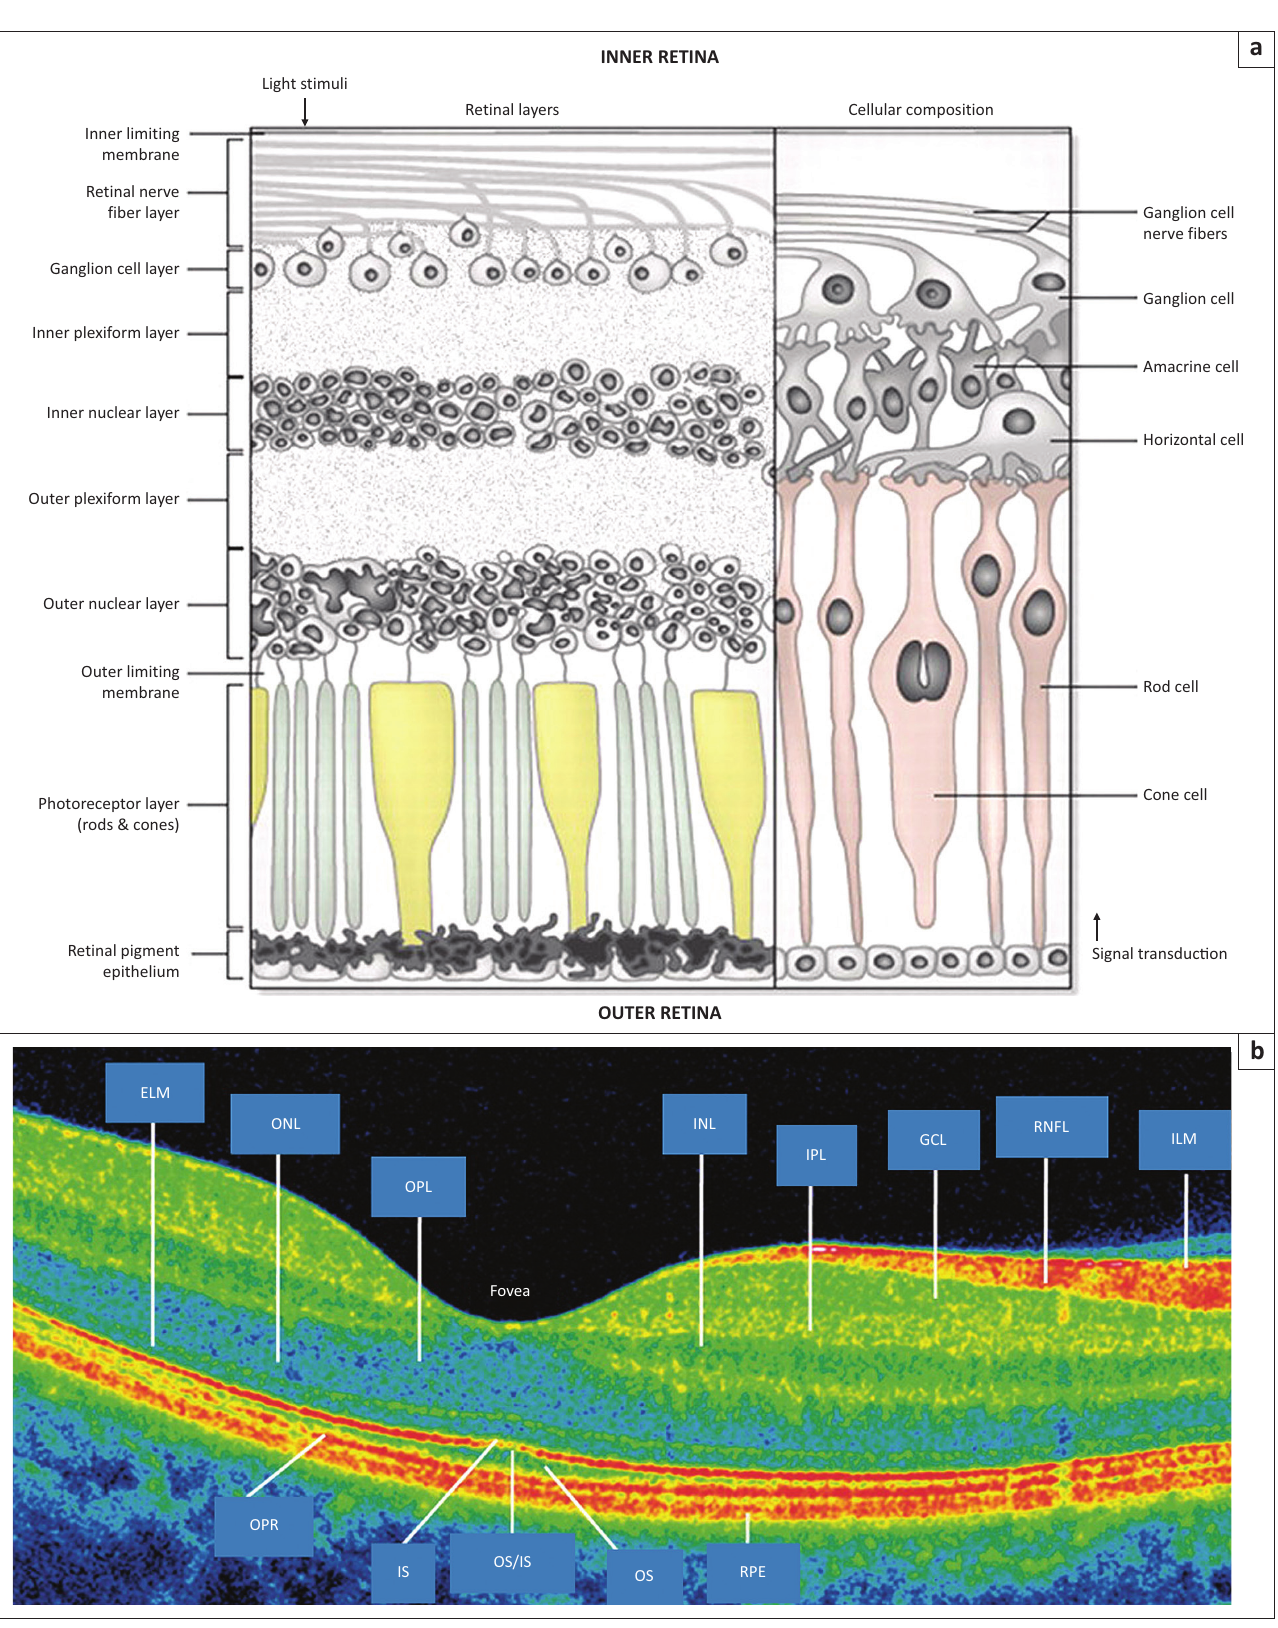
FIGURE 1: (a) Illustration of the retina. The optic nerve is formed by the fibres of the retinal nerve fibre layer which exit the retina at the optic disc. The nerve fibres of the retinal nerve fibre layer originate from the ganglion cells in the ganglion cell layer. (b) Cirrus HD-Optical coherence tomography B-scan. A false colour scheme is shown, which is generated by the differences between the retinal layers in tissue